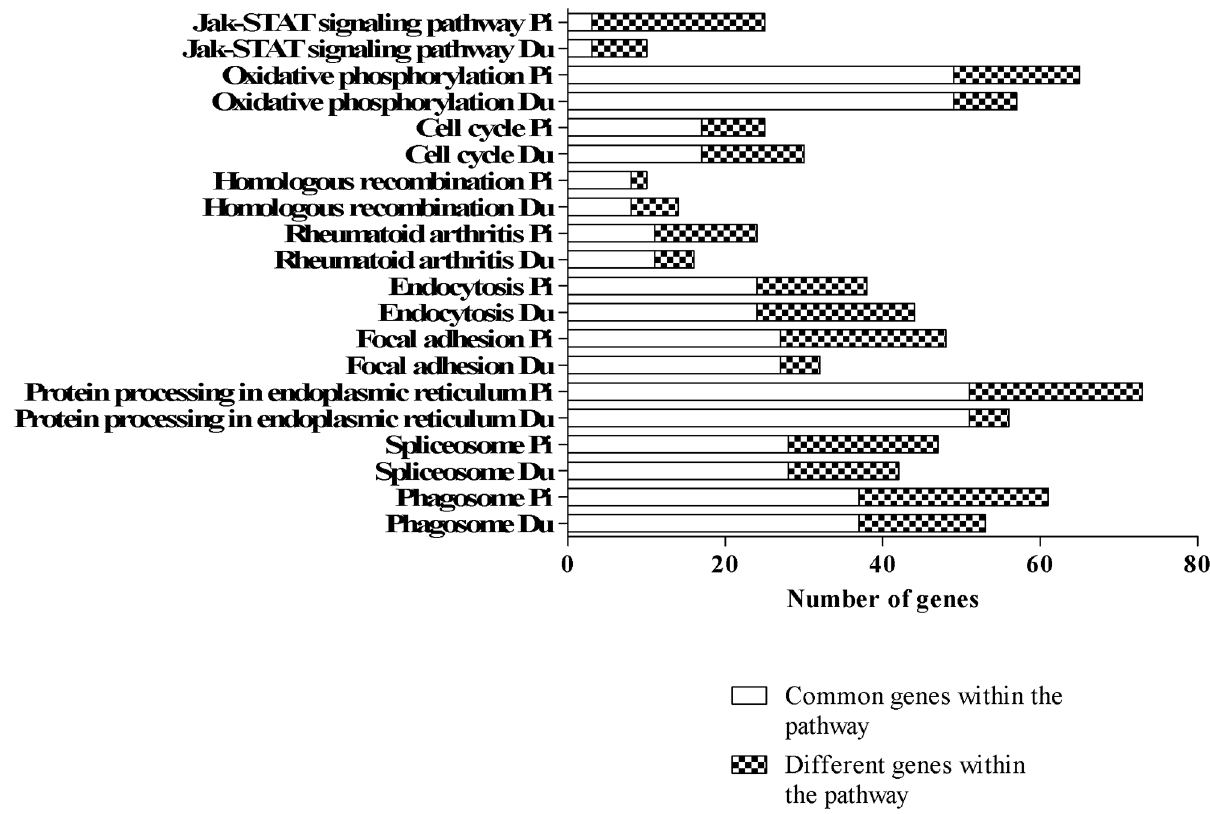
Fig 4. Number of genes per pathway. The numbers of genesare on the x-axis for the top 10 scored pathwaysof Pietrain (Pi) and Duroc (Du) lung DCs. Common geneswithin the pathway for each breed are depictedas a white bar and different genesare shown as a checked